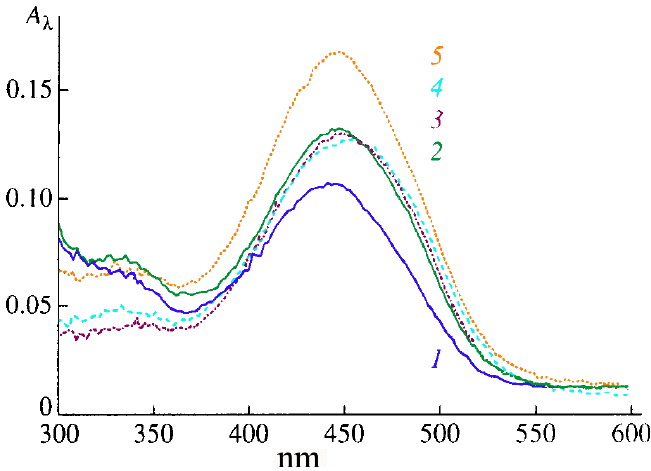
, (4) MgCl , and (5) NaCl at 10 mN/m. 2 2